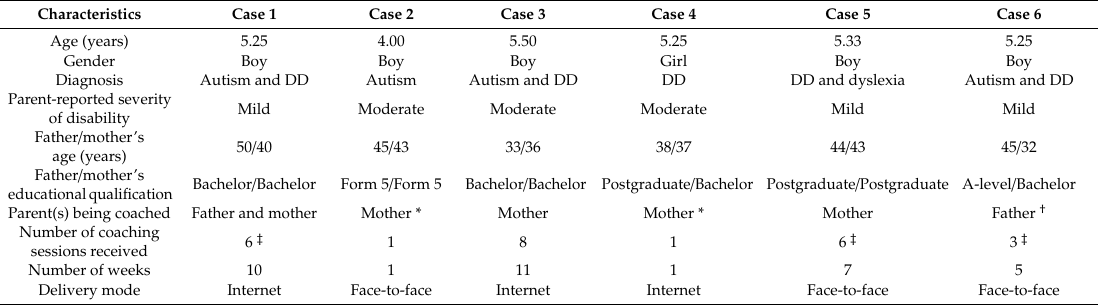
Table 1. Details of demographic characteristics of participants and the OPC sessions